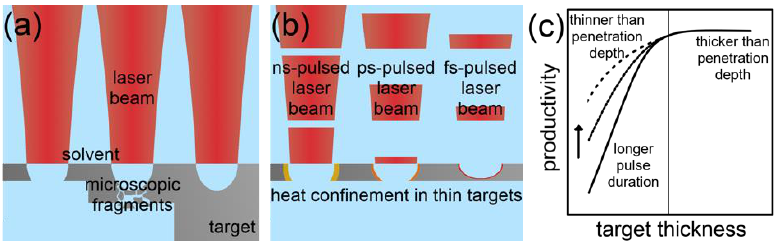
Figure 12. Illustration of the e ff ect of the target thickness in the laser ablation of metals in liquids ( a ) and the influence of the laser pulse duration on the heat confinement in thin targets ( b ). The diagram in ( c ) demonstrates relative e ff ects of di ff erent laser pulse duration on the dependence of the productivity on the ablation target thickness. In ( c ), both axes scale linearly. The trends shown in the diagram represent the interpretation of the combined results of the discussed literature in Section 2.2.1. In ( c ), the arrow and the less dense line style indicate the e ff ect of longer pulse duration on productivity. In ( c ), the vertical solid line in the center of the diagram marks the penetration depths of the laser pulse into the target material. Reprinted with permission from [66].